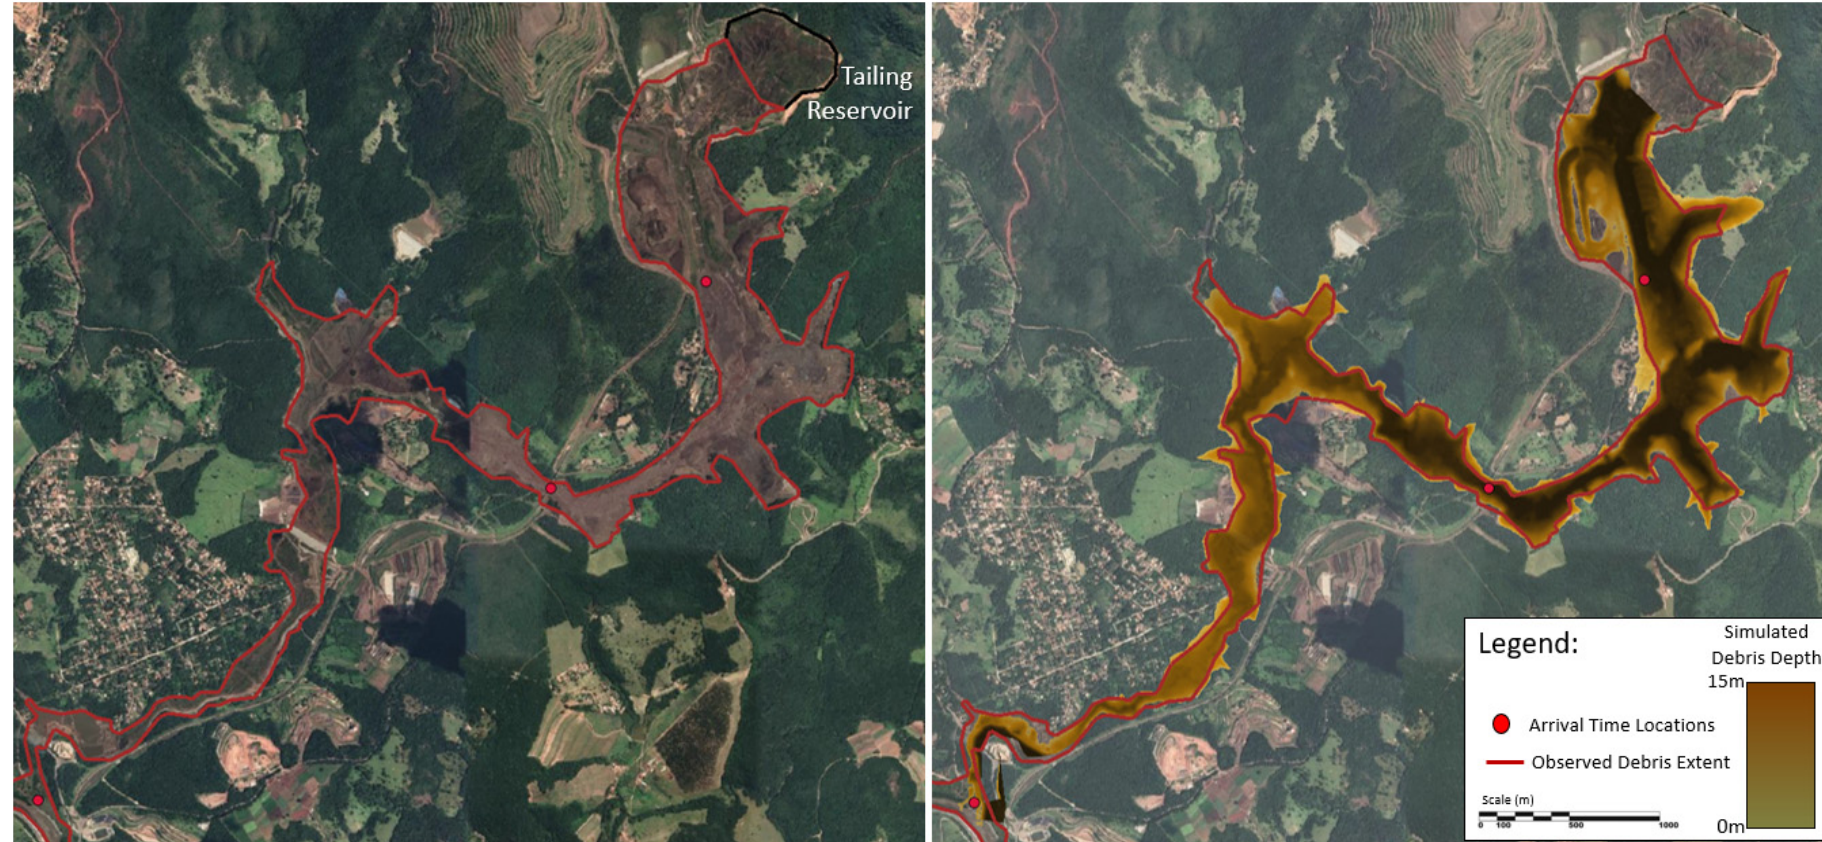
Figure 4. Comparison of HEC ‐ RAS model extents (depths) with observed damages extents (red).